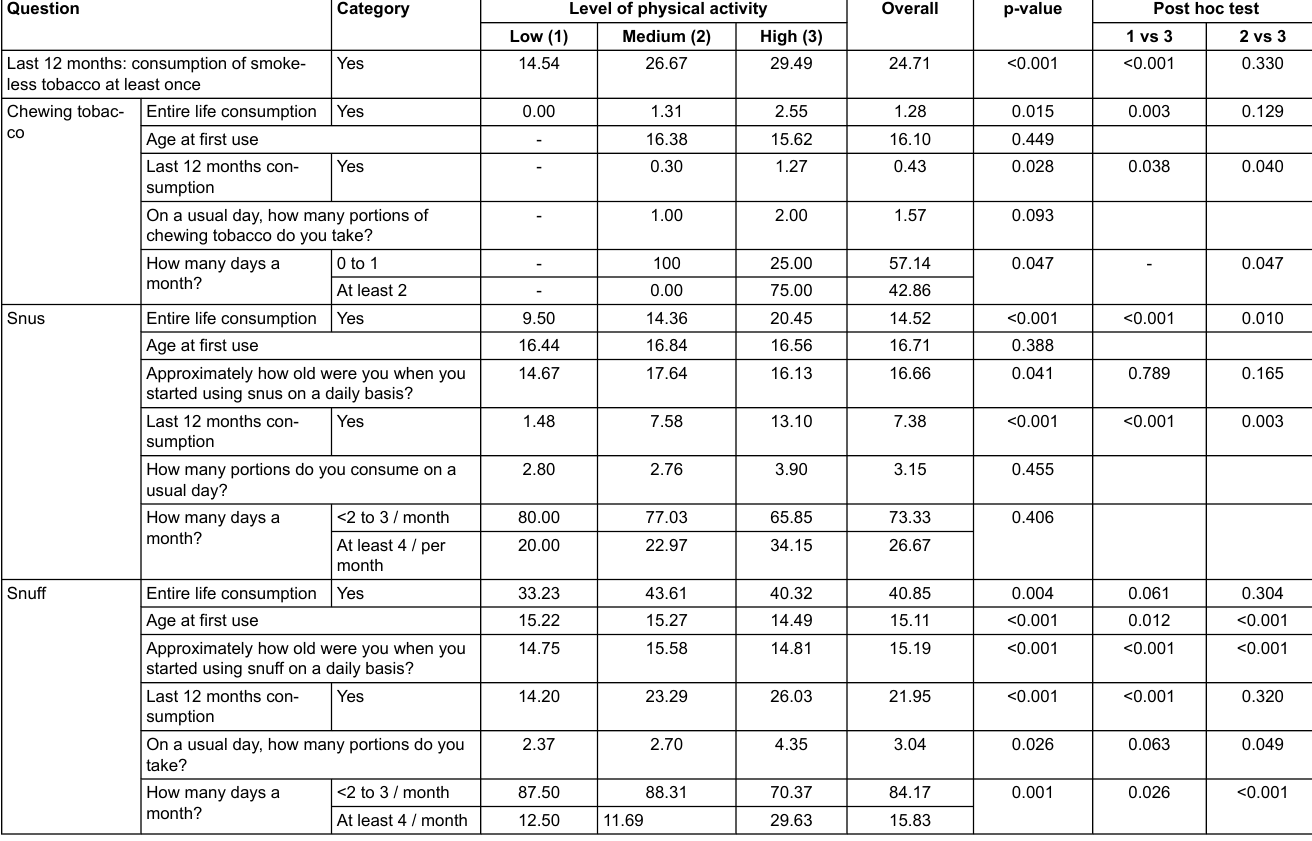
Table 4: Smokeless tobacco consumption by level of physical activity.